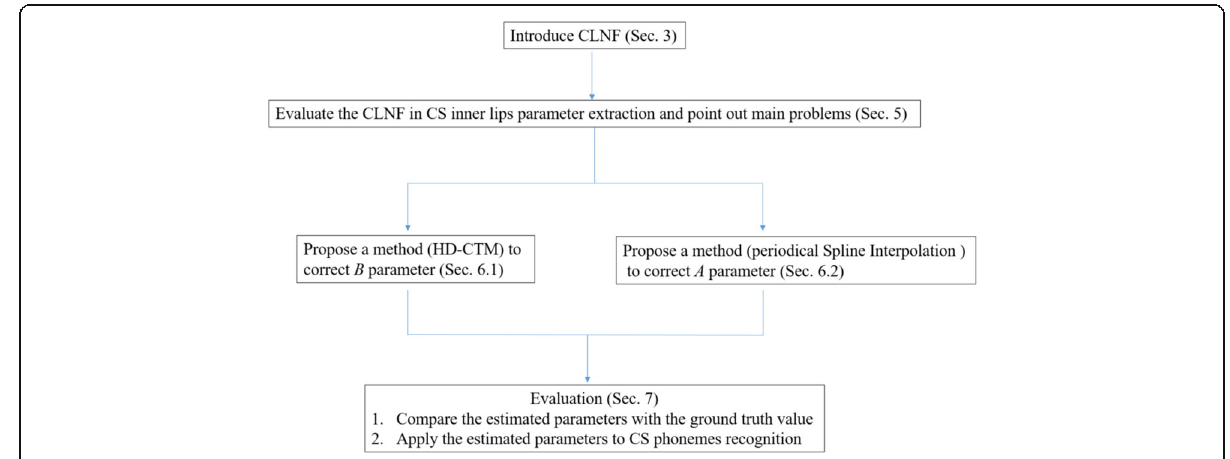
Fig. 2 An outline showing the logic arrangement of this